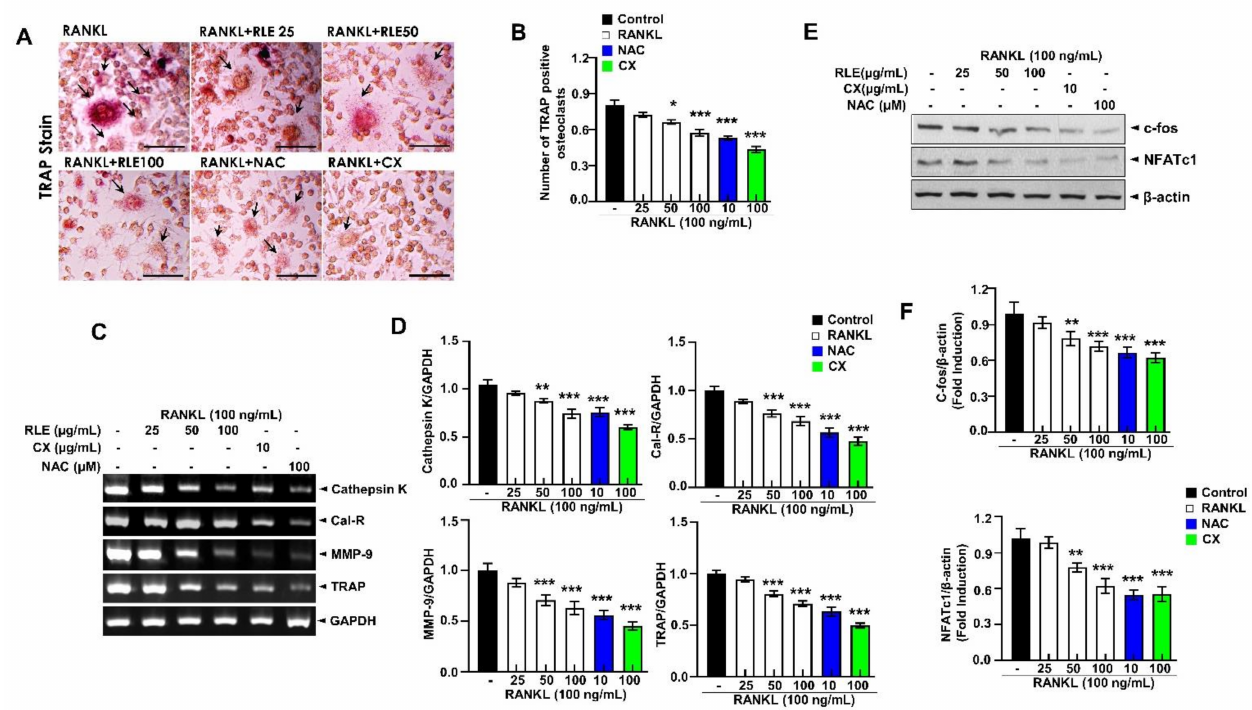
Figure 7. RLE inhibits the RNAKL-induced osteoclast formation in RAW264.7 cells. ( A ) Represen- tative TRAP-stained images (Scale bar = 200 µ m). ( B ) Quantitative analysis of TRAP-positive cells. ( C ) Expression of osteoclast-specific genes measured by RT-PCR. ( D ) Quantification of gene expres- sion. ( E ) Immunoblotting using antibodies against NFATc1, c-fos, and β -actin and ( F ) respective quantification analysis. Data are shown as mean ± SEM. ( n = 3, * p < 0.05, ** p < 0.01, *** p < 0.001 vs. RANKL) RLE, Ramie leaf extract; NAC, N-acetyl cysteine; MMP, matrix metallopeptidase; TRAP, tartrate-resistant acid phosphatase; cal-R,